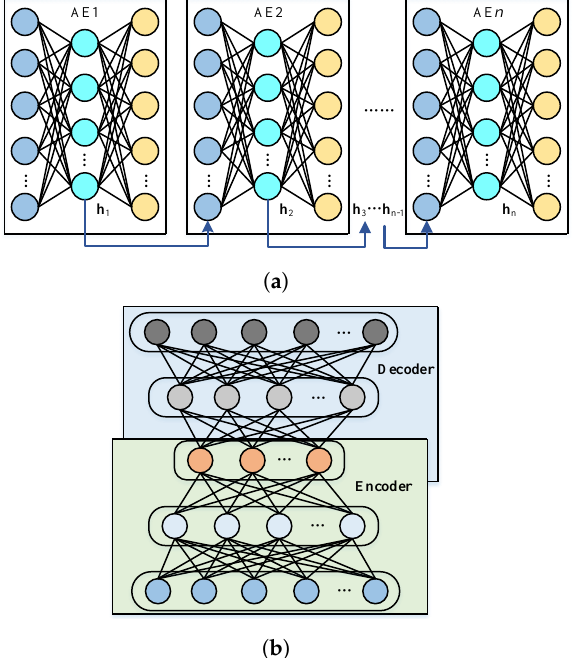
Figure 1. SAE Network Structure Diagram: ( a ) Schematic diagram of SAE pre-training stage; ( b ) Schematic diagram of SAE fine-tuning